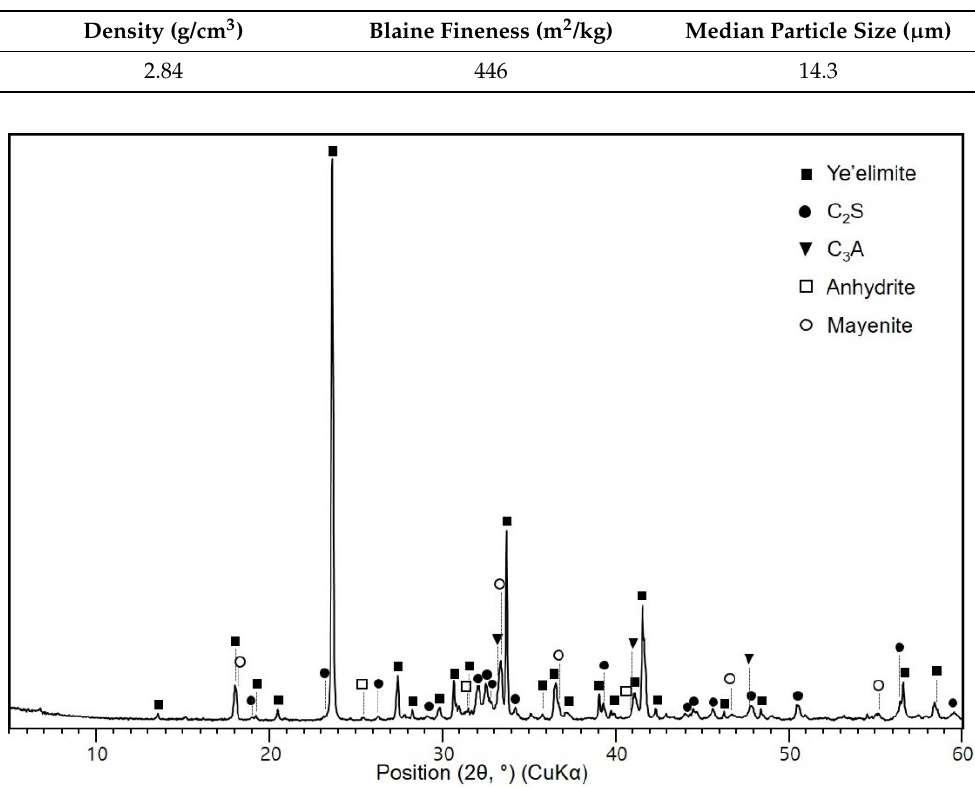
Figure 2. X-ray diffraction pattern of CSA cement. Database code: Ye’elimite (ICDD 33-0256); C 2 S (ICSD 79551); C 3 A (ICSD 151369); Anhydrite (ICSD 068592); Mayenite (ICDD 09-0413). Table 3. Phase composition of CSA cement as determined by Rietveld analysis of XRD